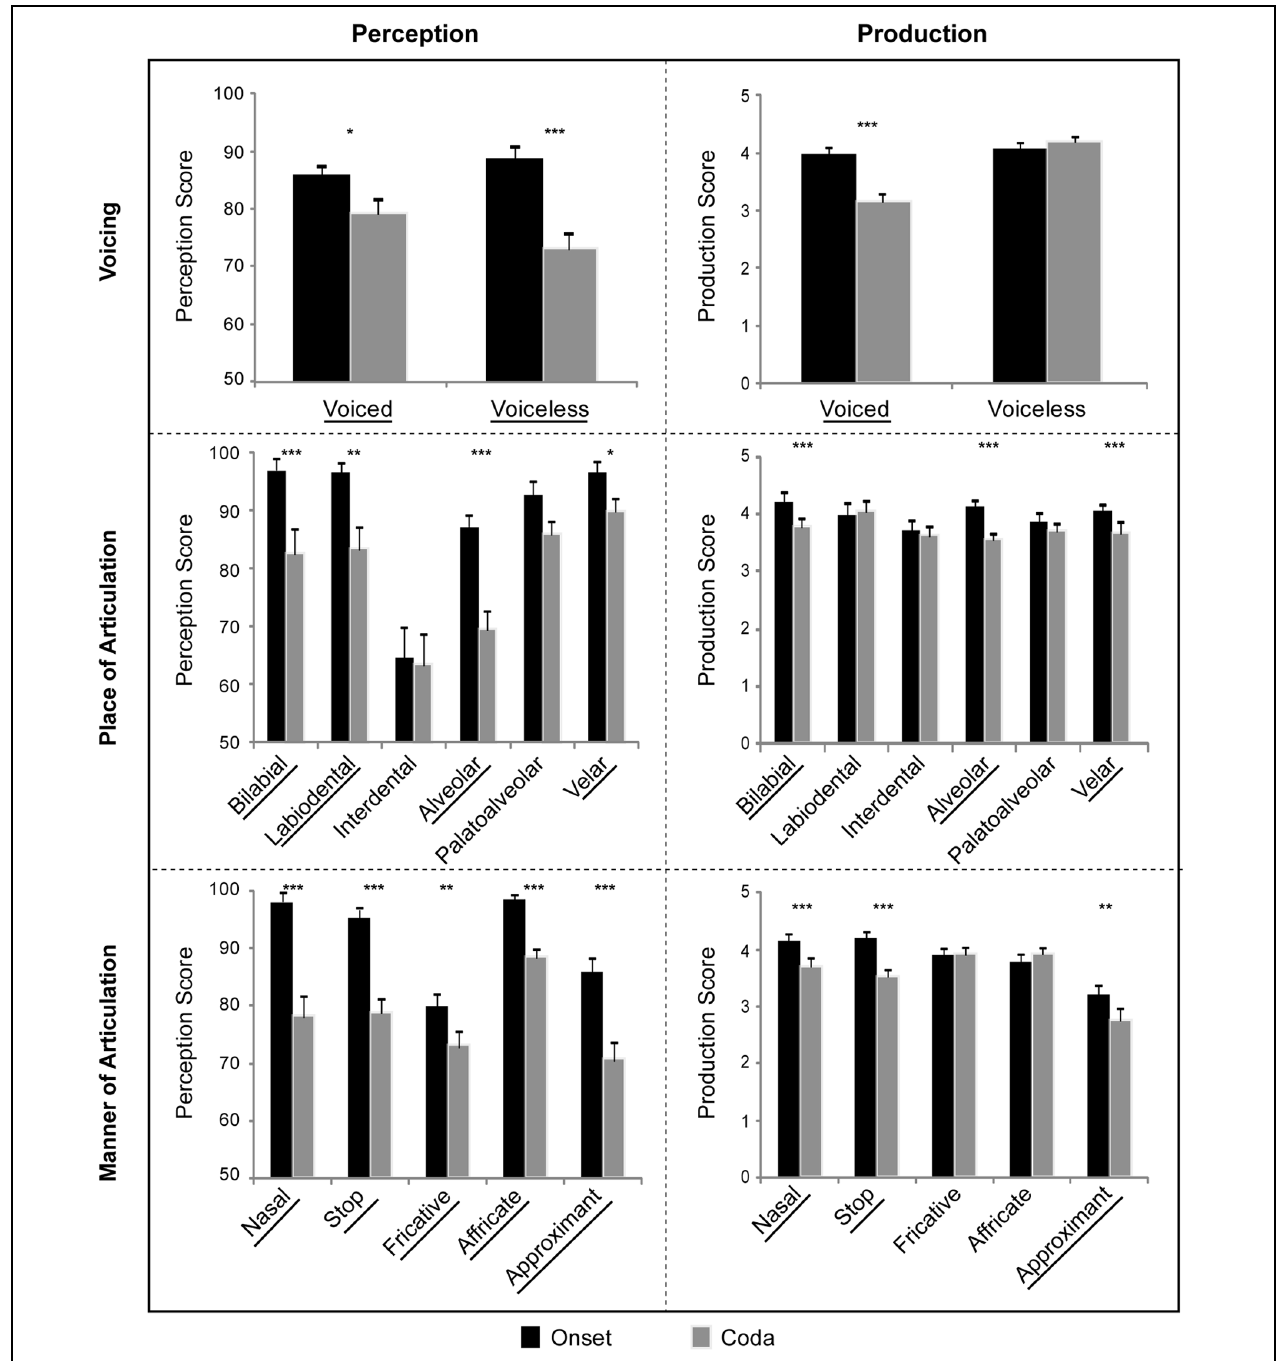
FIGURE 2 | Perception and production data of all 38 Chinese subjects separated by subcategories of voicing, place of articulation, and manner of articulation. Each consonant subcategory that showed significant positional asymmetry effect carries the underline mark. ( ∗∗∗ p < 0.001, ∗∗ p < 0.01, ∗ p < 0.05.)